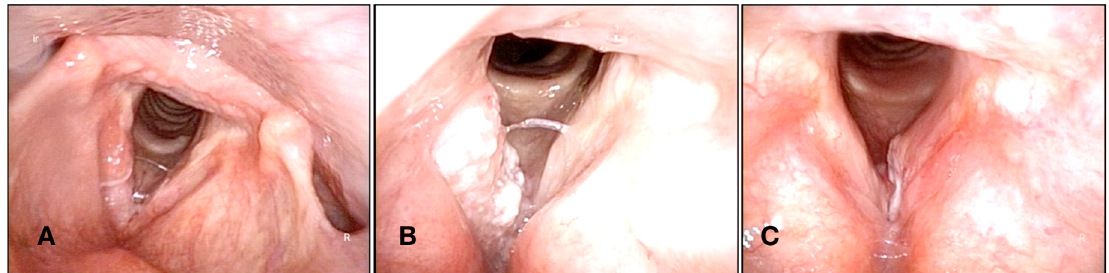
Figure 2. ( A ) Superficial lesion in the middle third of the right vocal fold. ( B ) Ulcerative-exophytic lesion involving all the right vocal fold. ( C ) Lesion affecting the anterior third of the left vocal fold. All of them were positive for malignancy and treated using CO 2 TOLMS.